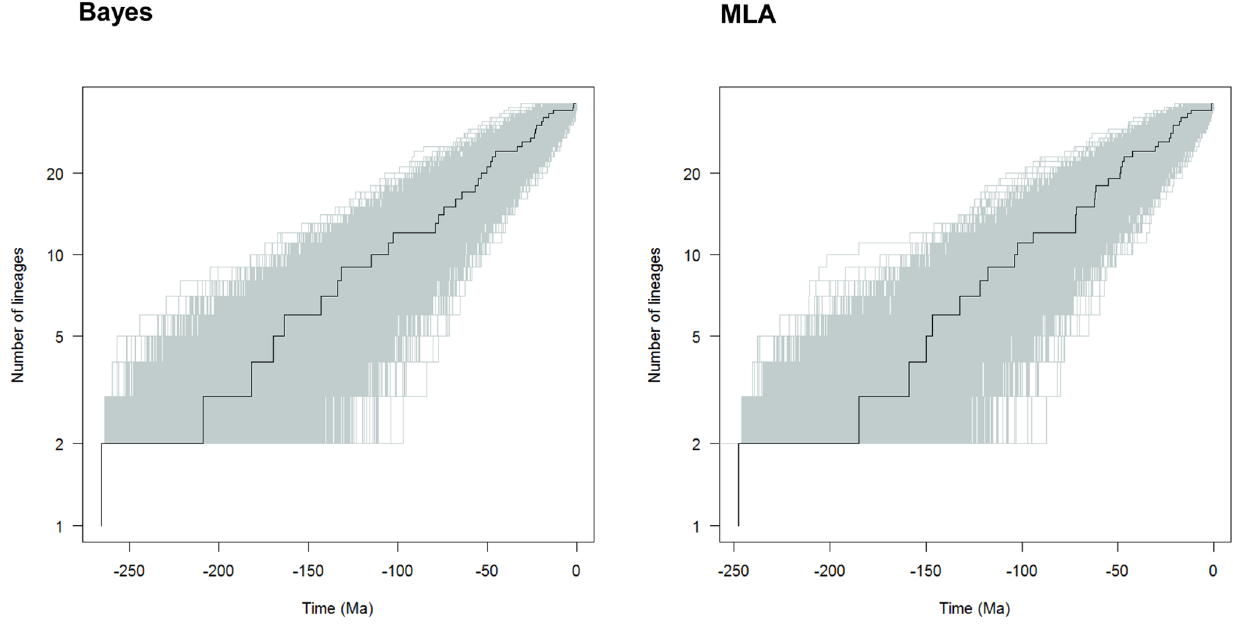
Figure 4. Testing departure of the empirical chronograms of Aeromonas from a constant rate diversification model. Dark lines represent the LTT plots obtained for empirical Bayesian (left) and MLA (right) Aeromonas phylogenies, while grey lines correspond to the LTT plots